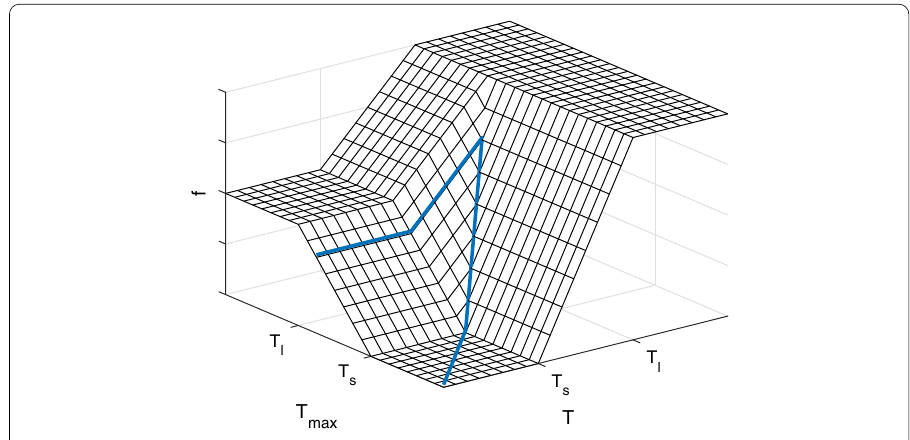
Fig. 4 Three-dimensional visualization of parameter interpolation. Material parameters are continuous in T and T max direction. The blue curve shows the evolution of the parameter when T max < T